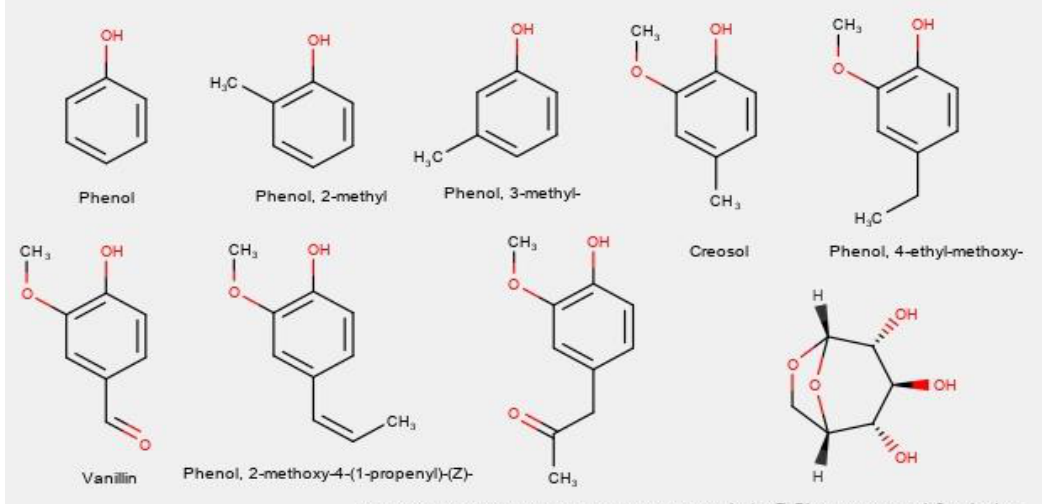
Figure 2. GC-MS determined common compounds from catalytic Etek lignin pyrolysis.